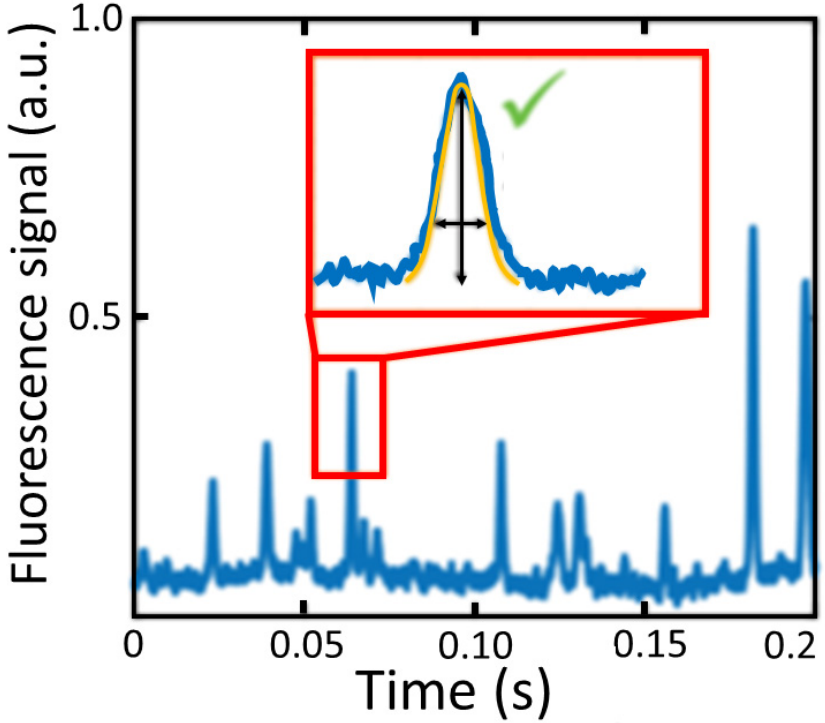
Figure 3. The electrical signal corresponding to the fluorescence time profile for the PVC test sample. In the inset, the matching to a predetermined pattern is